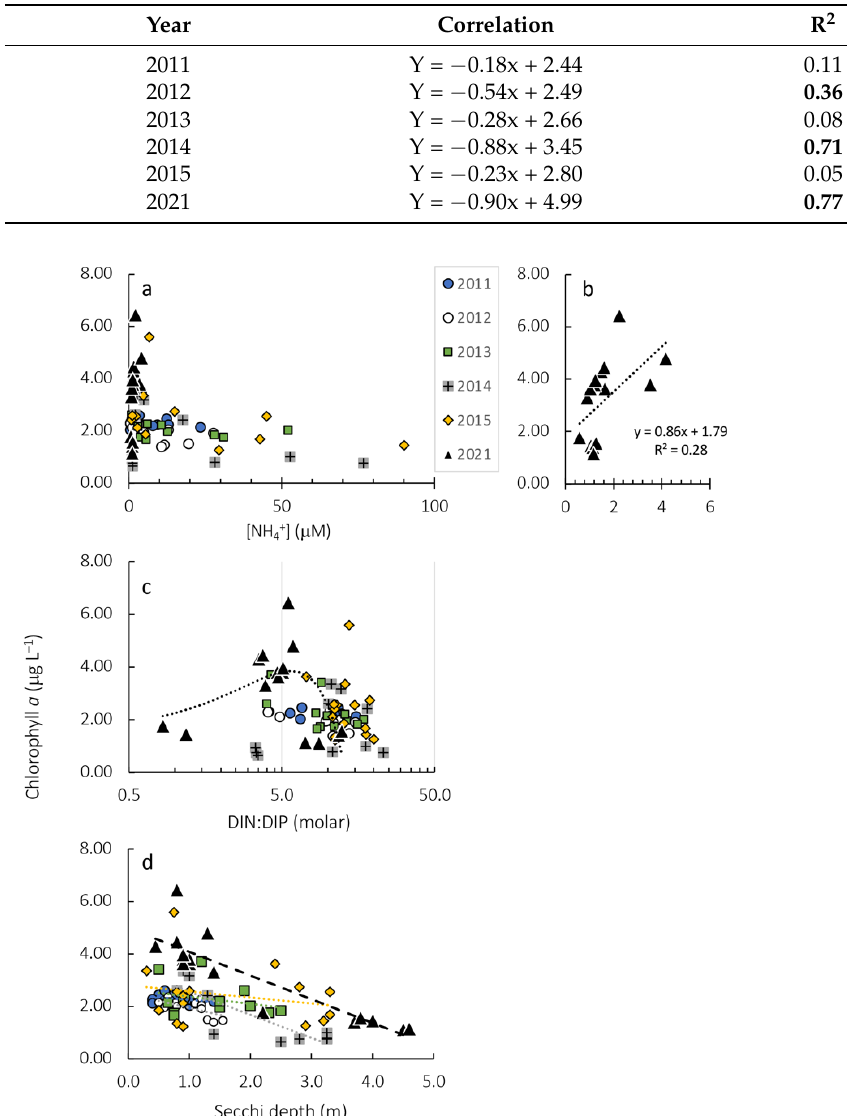
Figure 7. Chlorophyll a concentrations for all stations all years as a function of ambient NH 4 + (panel a ; expanded scale for 2021, panel b ), as a function of the ambient dissolved inorganic nitrogen:phosphorus ratio (panel c , with the line for 2021 data only), and as a function of secchi depth (panel d ). Note the inverse relationships between NH 4+ concentration (panel a ) and light availability (panel d ) and chlorophyll a . Table 1 summarizes the statistics for (panel d ).